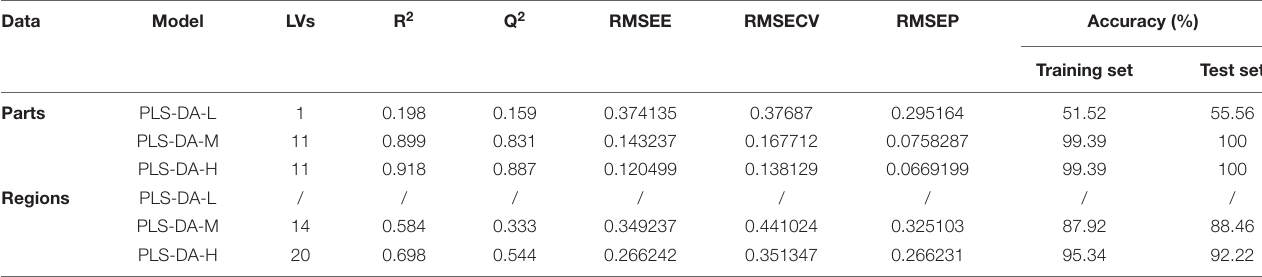
selected, and the synchronous 2DCOS, asynchronous 2DCOS and i2DCOS spectral images were automatically generated by the software Matlab2017b. The image size can be chosen according to the processing power of the computer (32 × 32 pixel, 64 × 64 pixel and 128 × 128 pixel), and the generated 2DCOS images were stored in JPEG image format with the size as 64 × 64 pixel in the corresponding folder for building ResNet model. Using the Kennard-stone algorithm, all datasets were divided into training set (60%), test set (30%), and external validation set (10%). The process of generating all types of 2DCOS spectra images is shown in Supplementary Figure 1 .